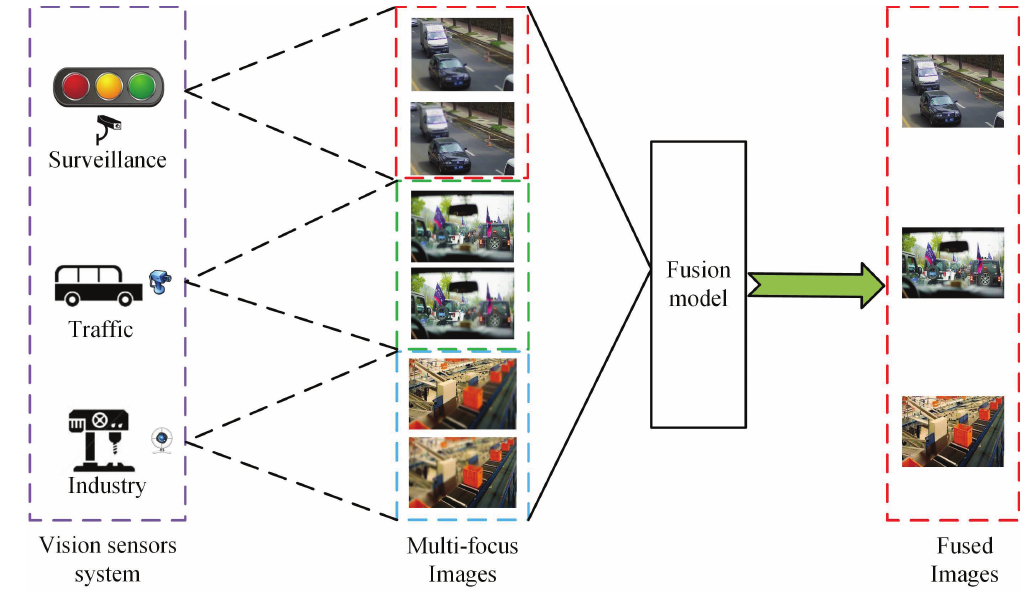
Figure 1. Applications of vision sensor systems (VSS) in real